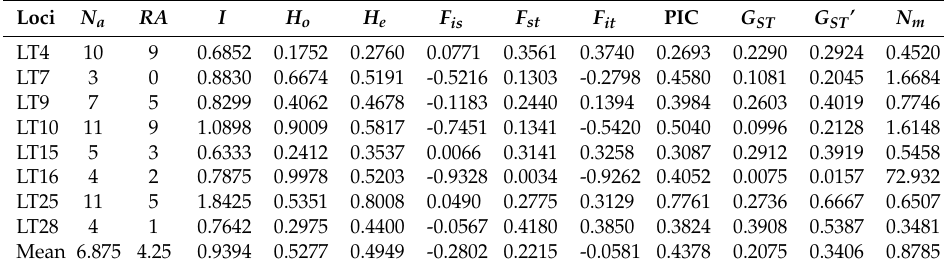
Table 1. Genetic characteristics of eight microsatellite loci in Lancea tibetica populations. Observed number of alleles ( N a ), rare alleles ( RA ), Shannon information index ( I ), observed heterozygosity ( H o ), Nei’s expected heterozygosity ( H e ), inbreeding coefficient ( F is ), fixation index ( F st ), inbreeding coefficient at the total sample level ( F it ), the polymorphism information content (PIC), Nei’s coefficient of genetic differentiation ( G ST ), Shannon’s coefficient of genetic differentiation ( G ST ’ ),gene flow ( N m